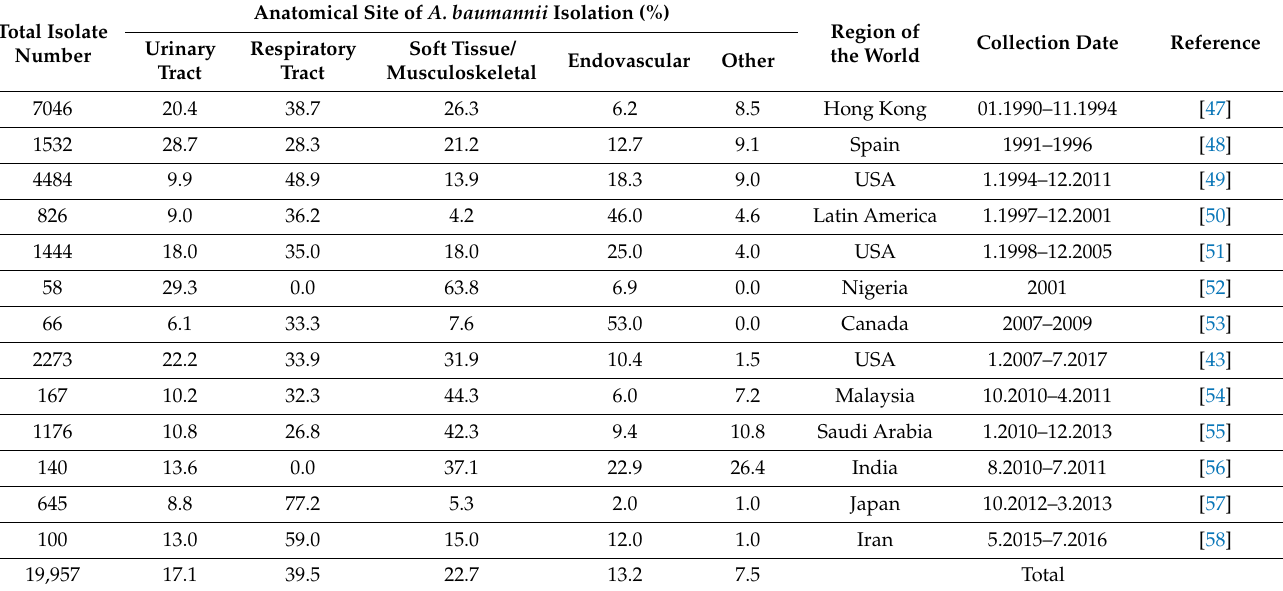
Table 1. Anatomical sites of isolation of A. baumannii clinical